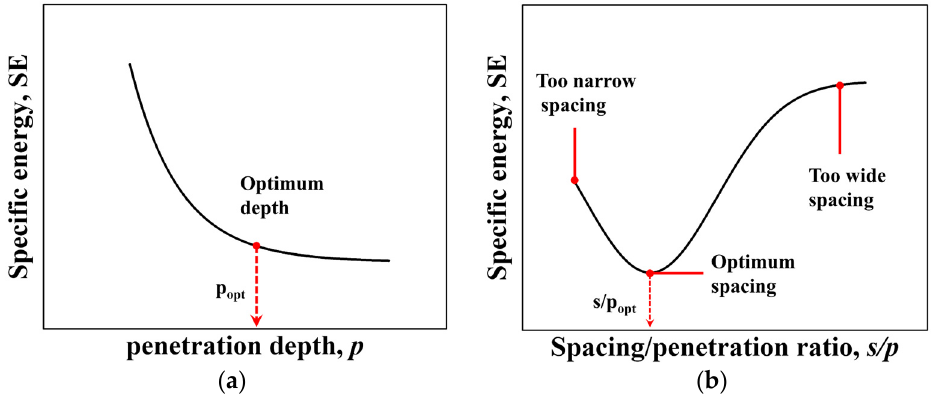
Figure 1. Variation in SE with ( a ) penetration depth and ( b ) spacing (reproduced with permission from Raf. [7]. 2007. Balci and Bilgin).